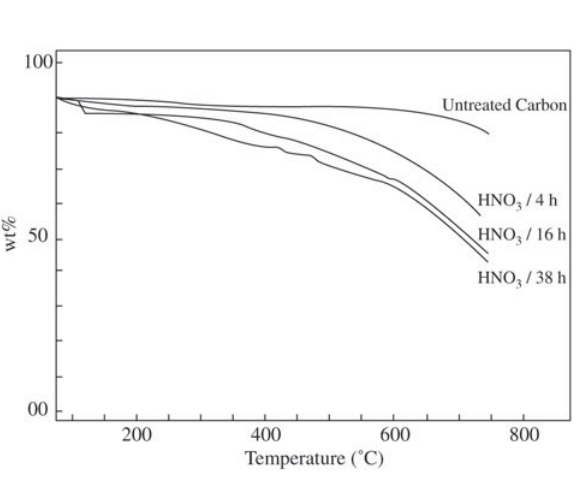
Figure 3. TG profiles for the different HNO